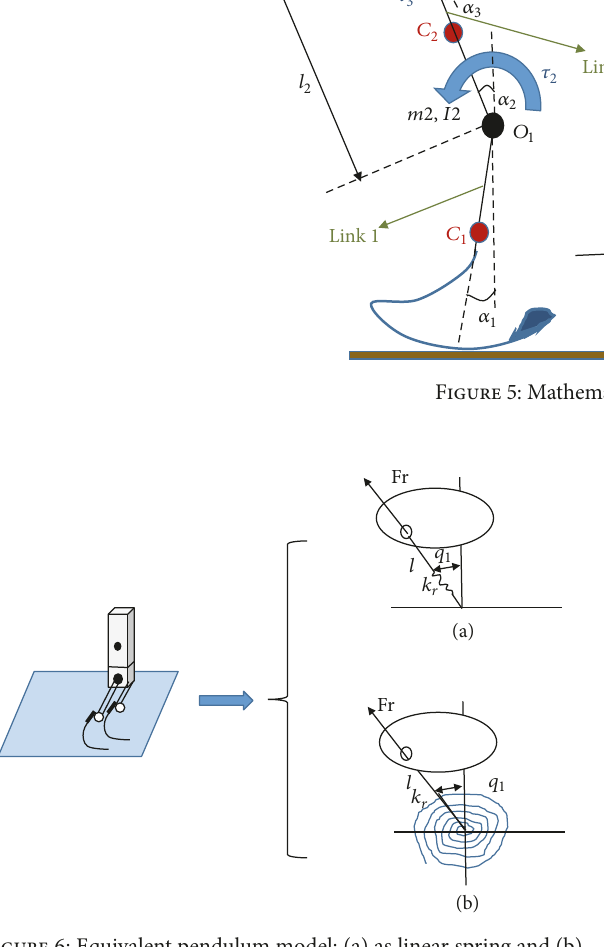
Figure 6: Equivalent pendulum model: (a) as linear spring and (b) as rotational